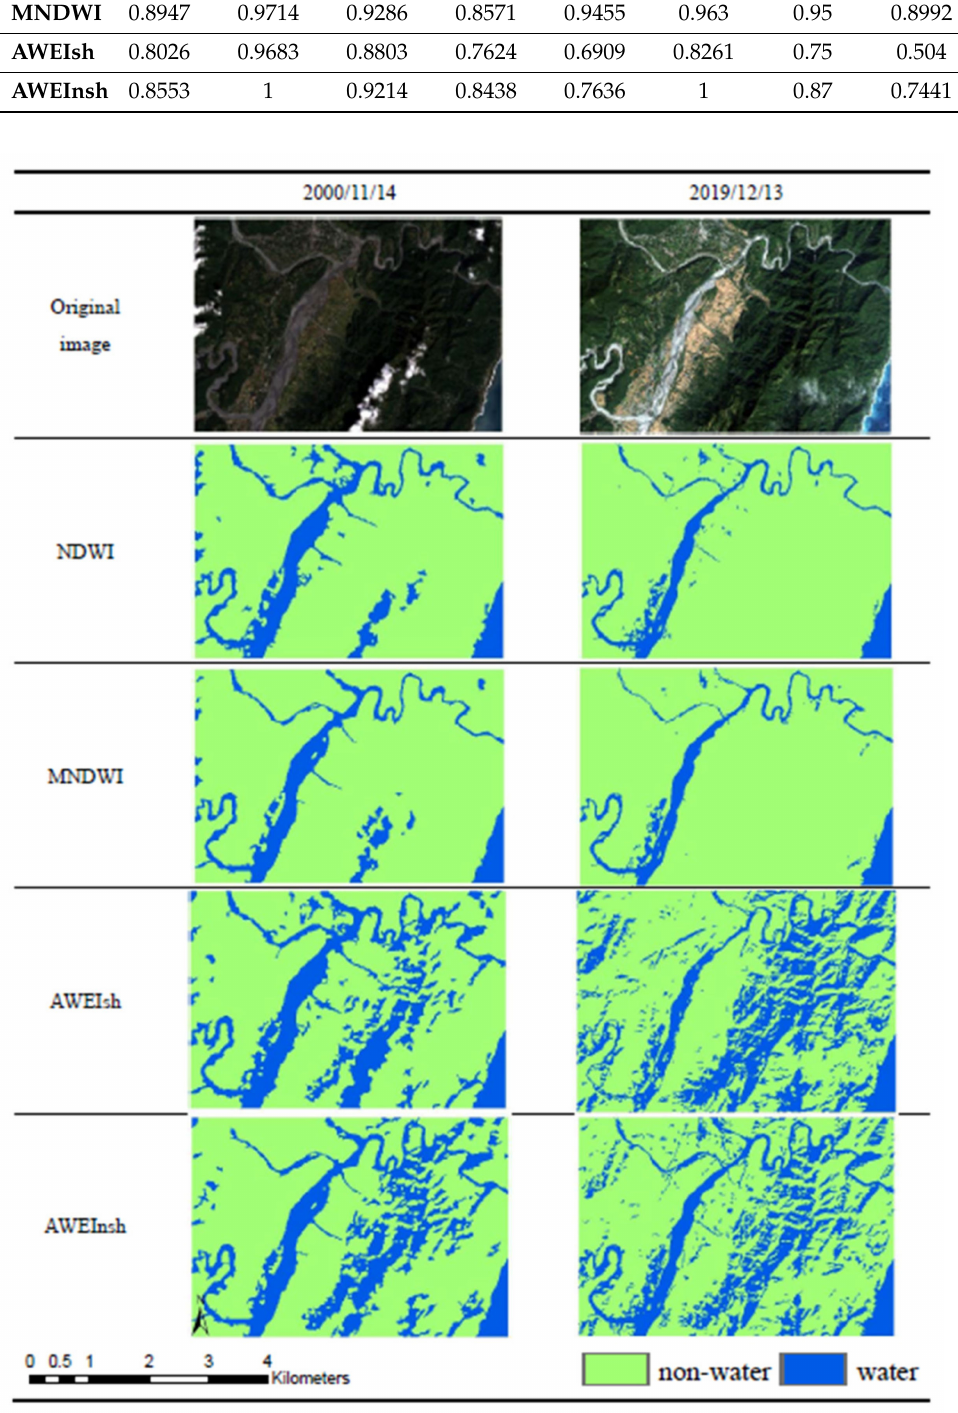
Figure 8. Xiuguluan River: Results of spectral water body indices in terms of water body extraction on different